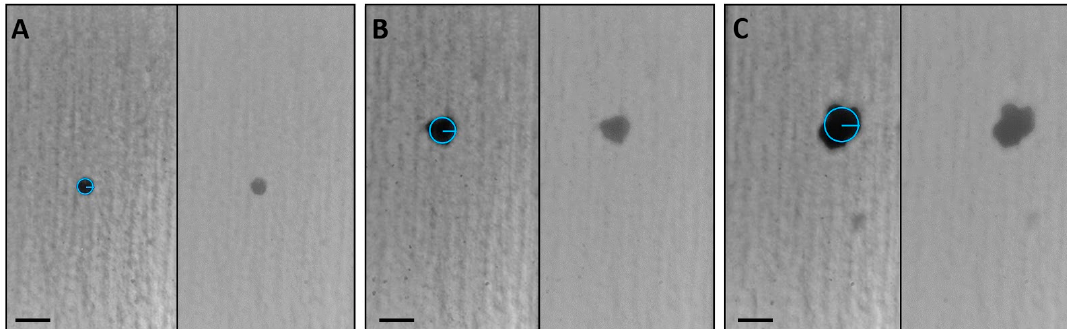
Figure 4. Images of frames collected for three representative samples. A small and rounded spheroid ( A ), a medium-sized sample showing a slight deviation from sphericity ( B ), and a large non-spherical outlier ( C ). For each panel, the brightfield (right) and the elaborated image (left) are shown. For better visualization, the circular references created by the software were graphically overlapped. Scale bars: 200 µm. Videos of the relative images are presented in Video S1.